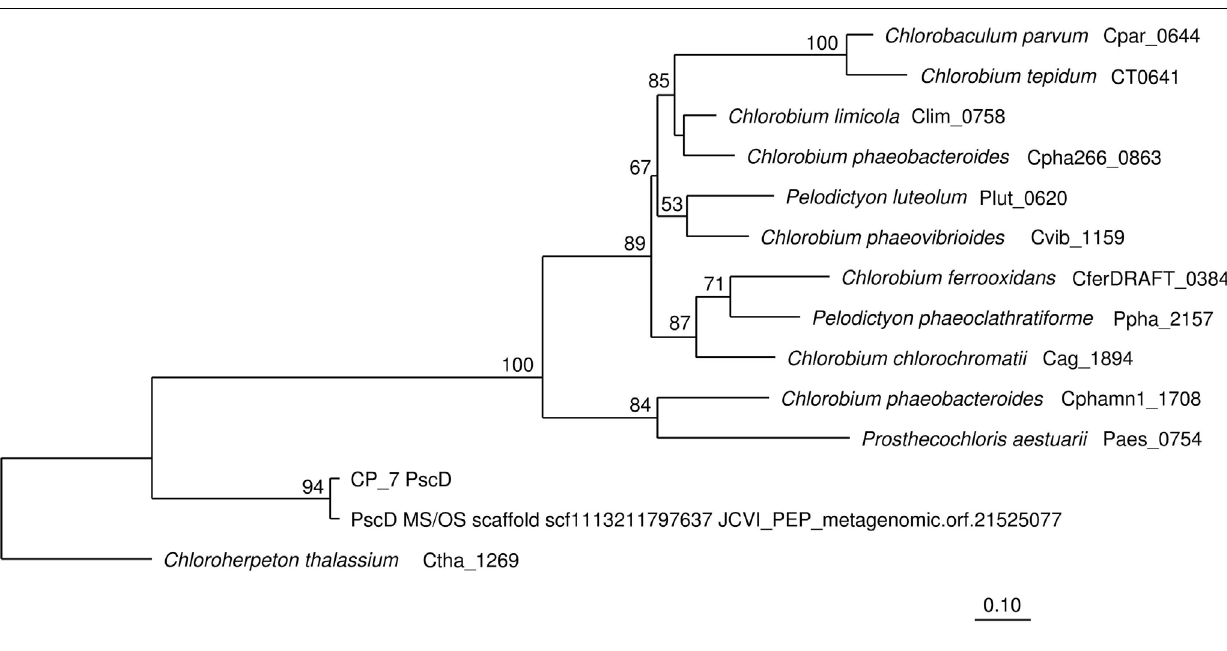
FIGUREA4 | Maximum-likelihood phylogenetic tree of Chlorobi PscD sequences from metagenomes and sequenced genomes .The tree was produced using the program PhyML from PscD alignments containing 172